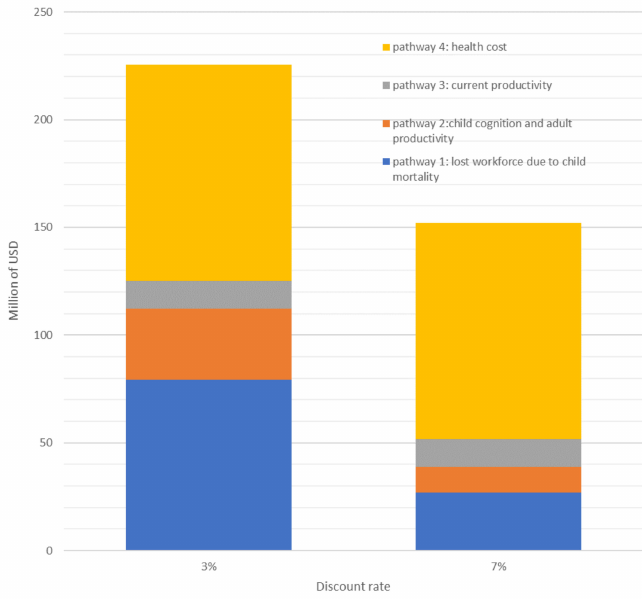
Figure 2. Impact of discount rates on economic burden of